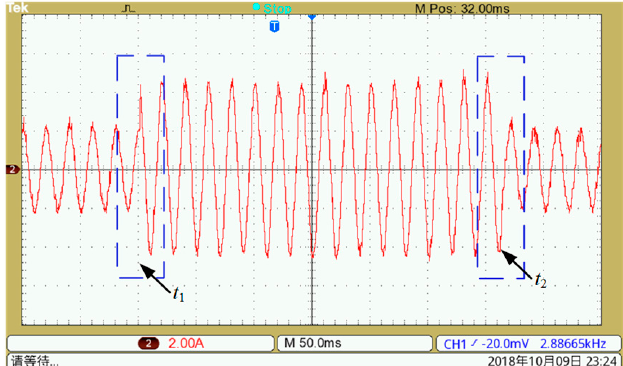
Figure 22. Dynamic performances when the proposed control strategy is employed.